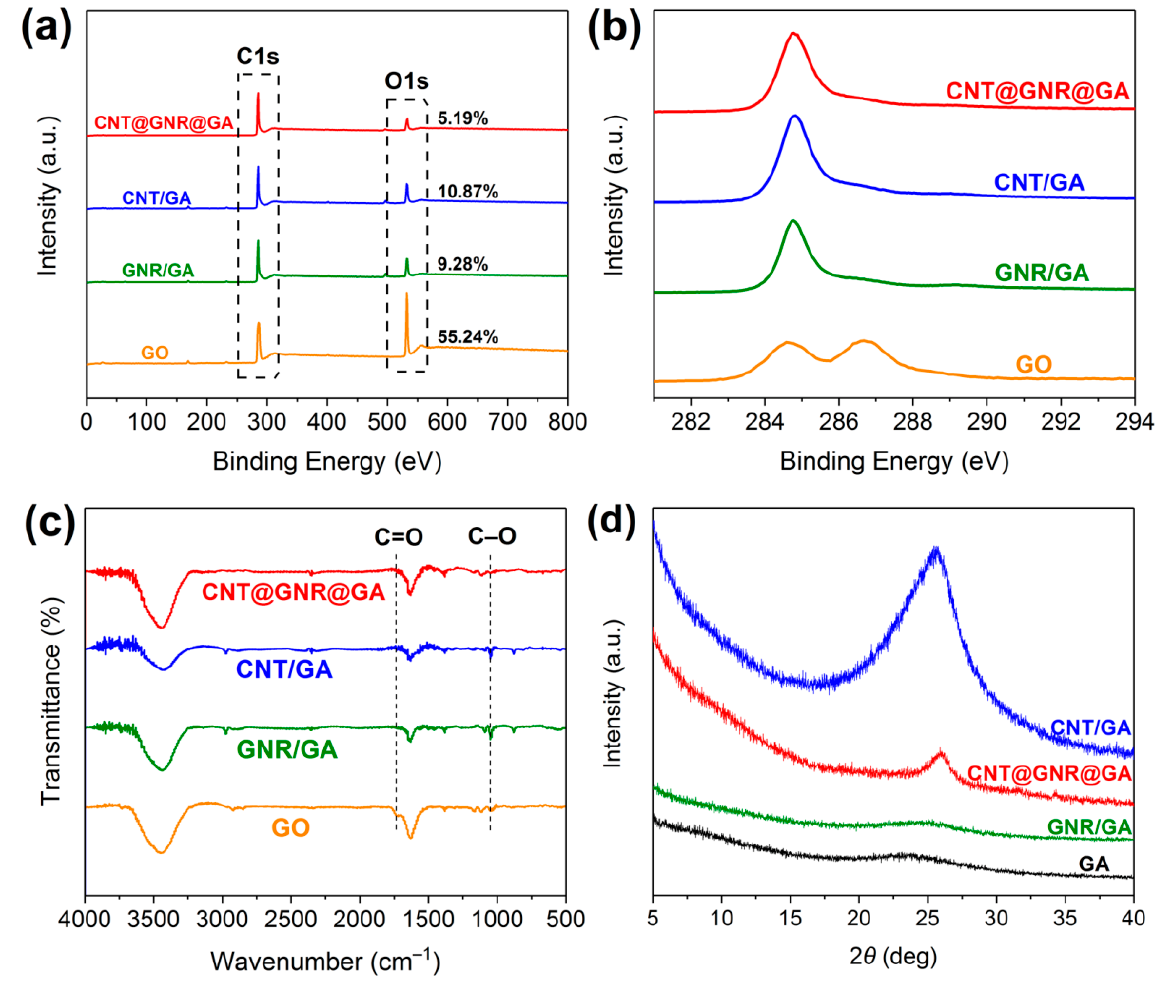
Figure 2. ( a ) XPS large survey spectra, ( b ) XPS C1s spectra, ( c ) FTIR spectra, and ( d ) XRD patterns of the resulting aerogels.